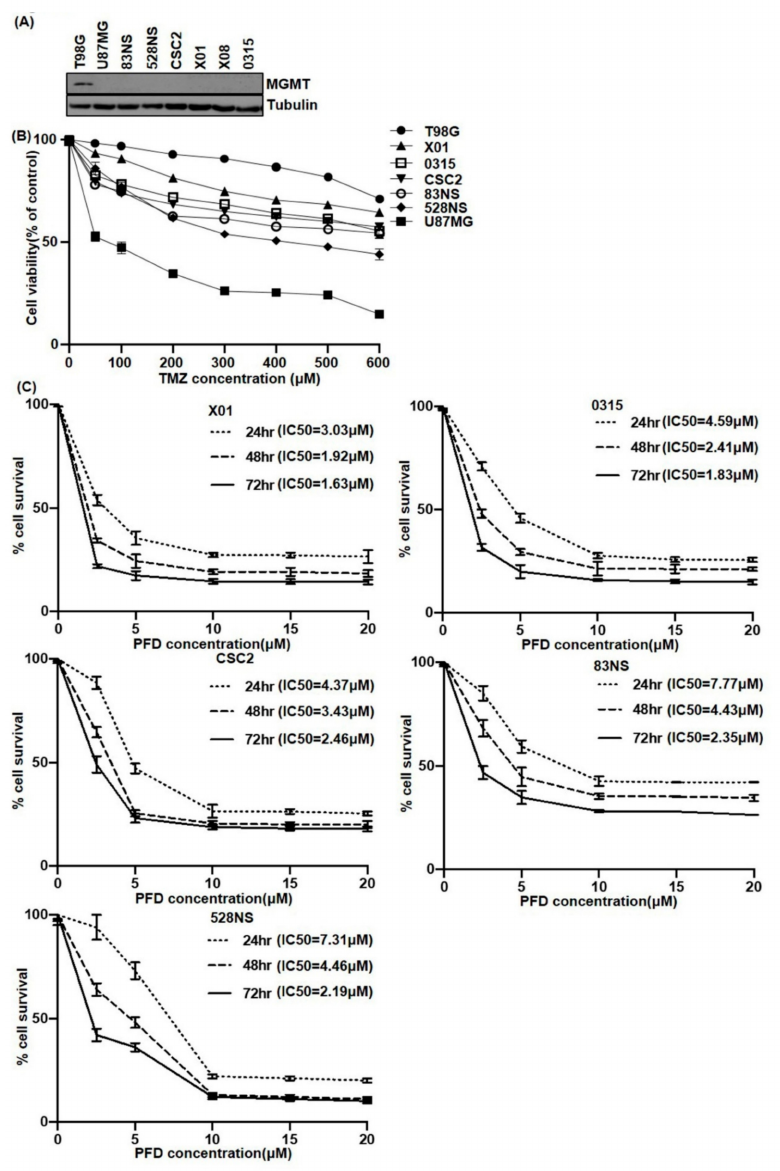
Figure 1. GSCs and glioma cell proliferation upon TMZ and PFD treatment. ( A ) MGMT protein expression in T98, U87MG glioma cells, and 6 GSCs by western blot. Tubulin was used as loading control. ( B ) T98, U87MG glioma cells, and X01, CSC2, 528NS, 83NS, and 0315 GSCs were